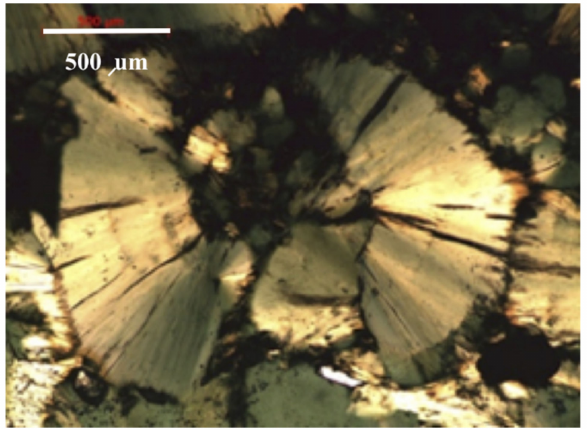
Figure 5. Photomicrograph showing radial aggregates of Fe,Mn-chlorite